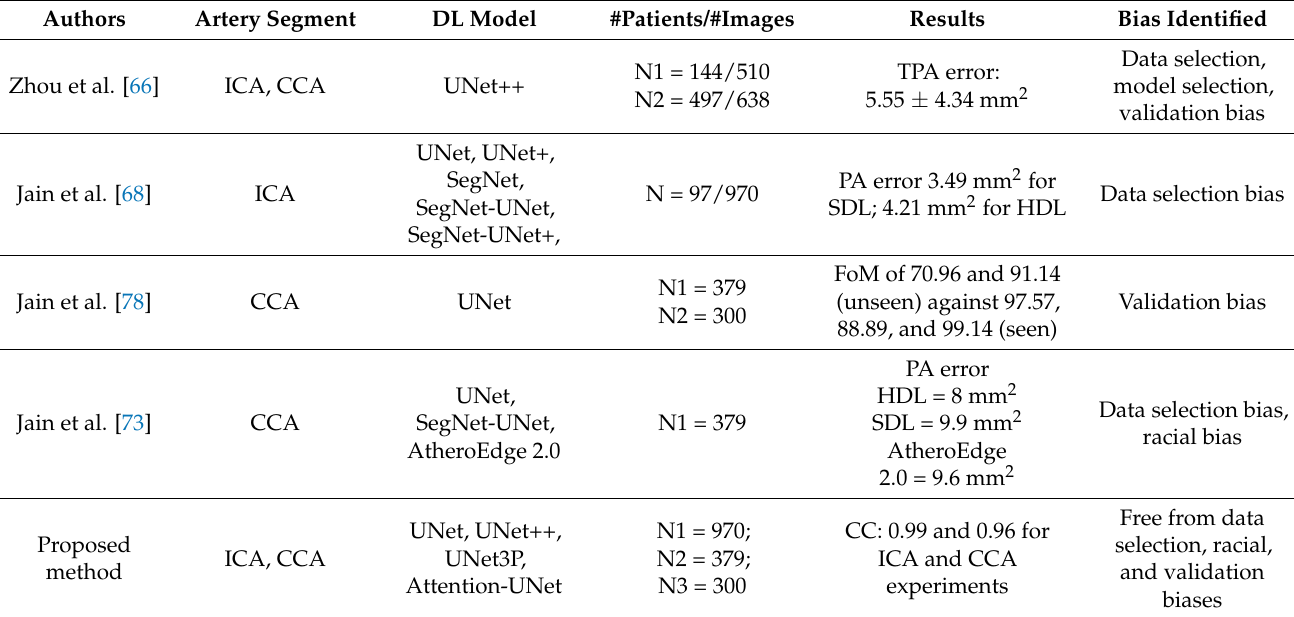
Table 8. Benchmarking current research against previous